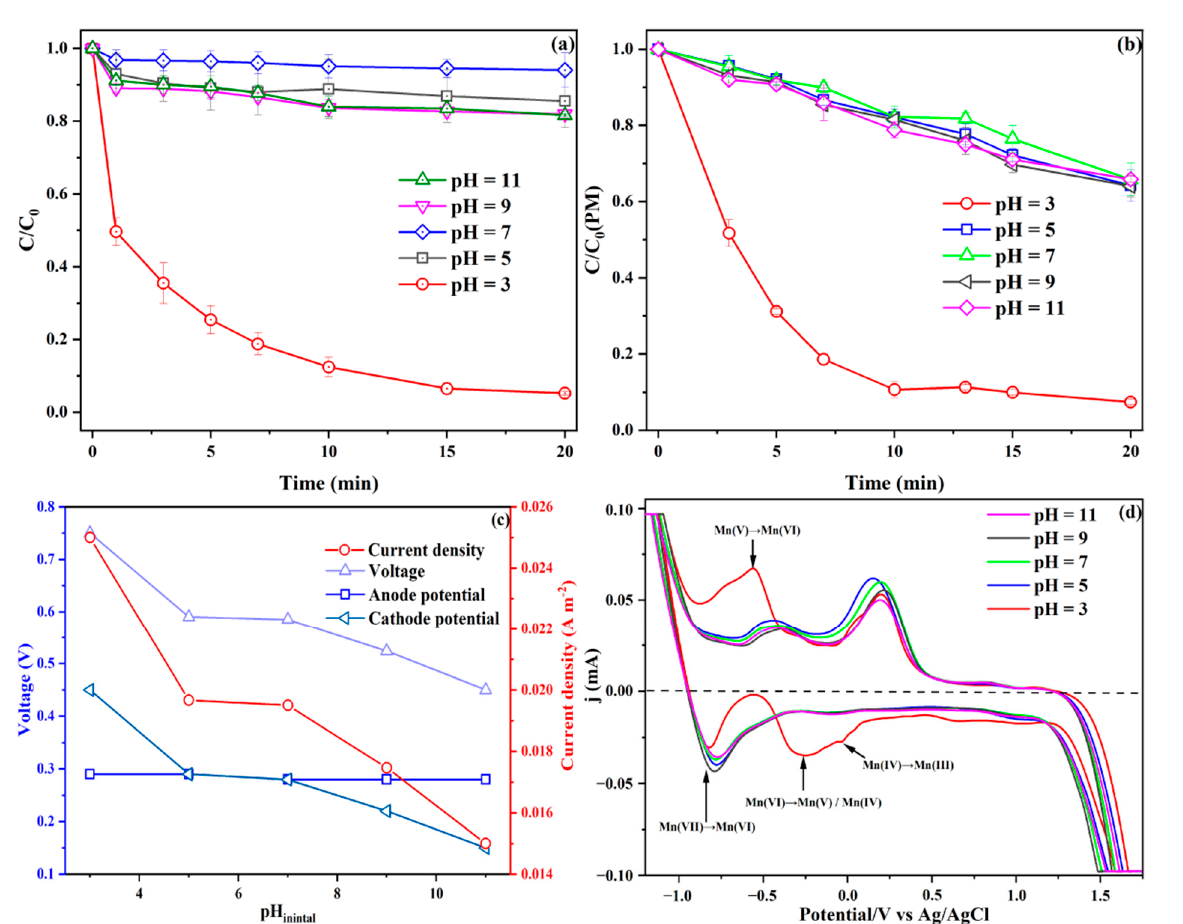
Figure 3. DCF removal ( a ), PM consumption ( b ), voltage, cathode/anode potential and current density ( c ), and cyclic voltammetry curve ( d ) at different pH values ([PM] 0 = 30 µM; [DCF] 0 = 60 µM; external resistance = 0 Ω ).